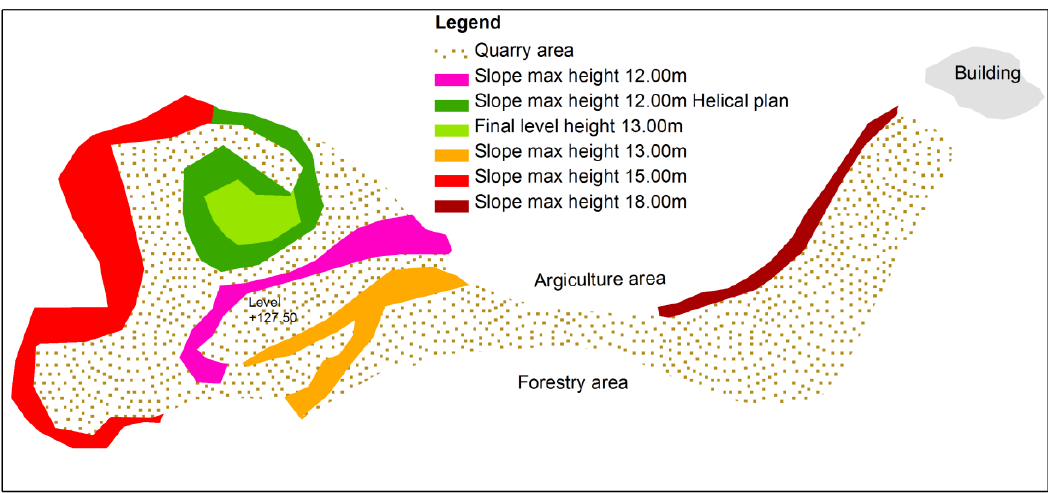
Figure 2. Topographical survey of the quarry site in the Asvestades area, scale 1:2000.